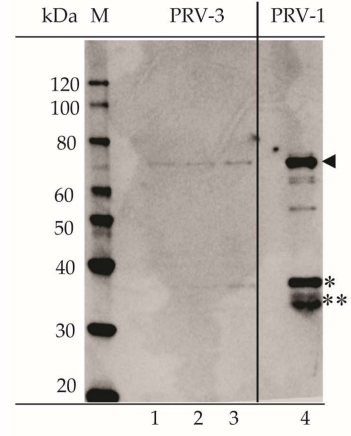
Figure 8. Purified PRV-3 (Lanes 1–3; Ct values for loaded virus particles were 22.7, 20.6 and 20.6, respectively) and PRV-1 (Lane 4; Ct value 17.1) particles analyzed by western blotting using antiserum against